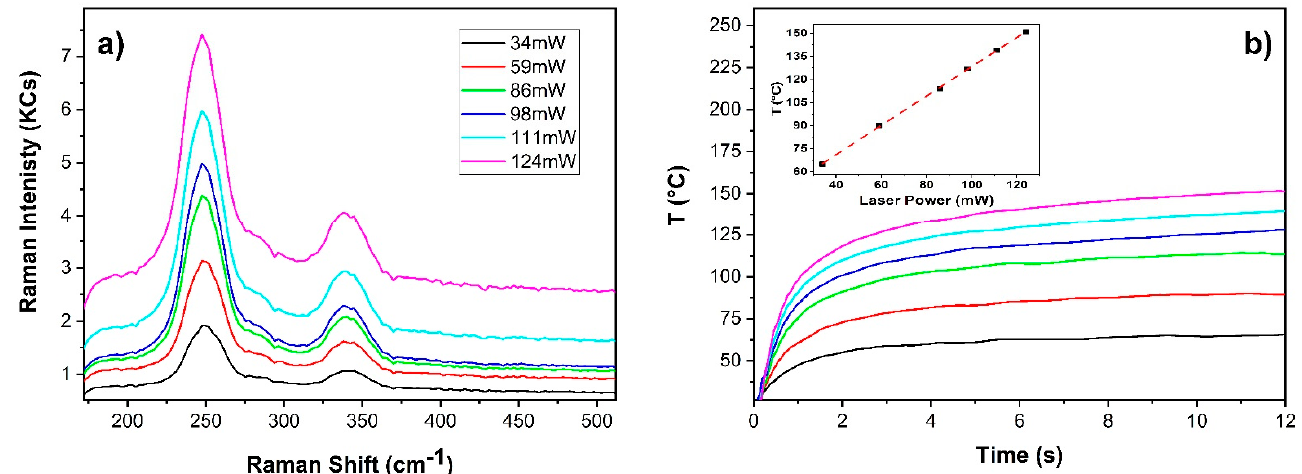
Figure 6. Cinnabar in linseed oil paint layer: ( a ) Raman spectra (exc. wav. 785 nm) achieved with 12 s integration time at different laser power; ( b ) corresponding temperature profiles and temperature dependence on power at 11.6 s (inset).